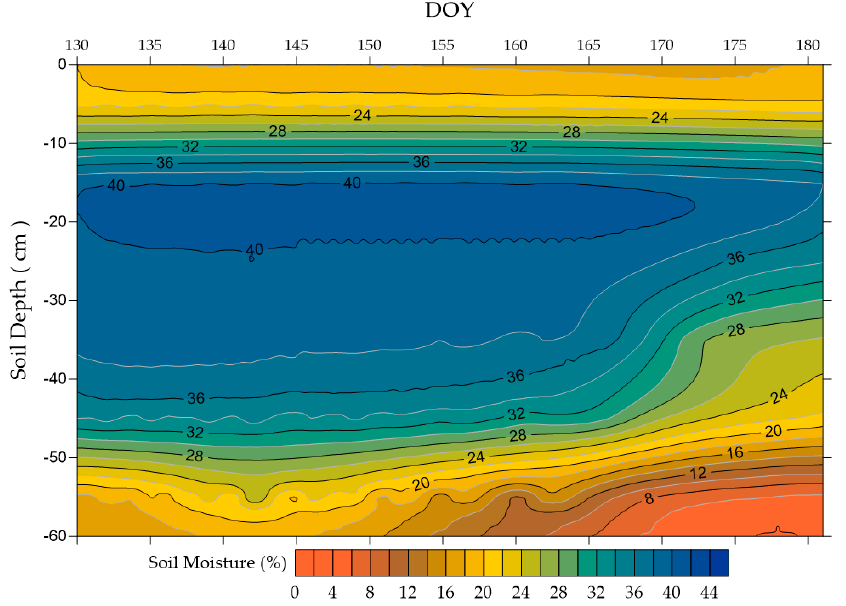
Figure 6. Soil water content isolines (%) in the irrigated spring potato crop (field 2) for 10 May–9 July 2019 (DOY: 130–181).